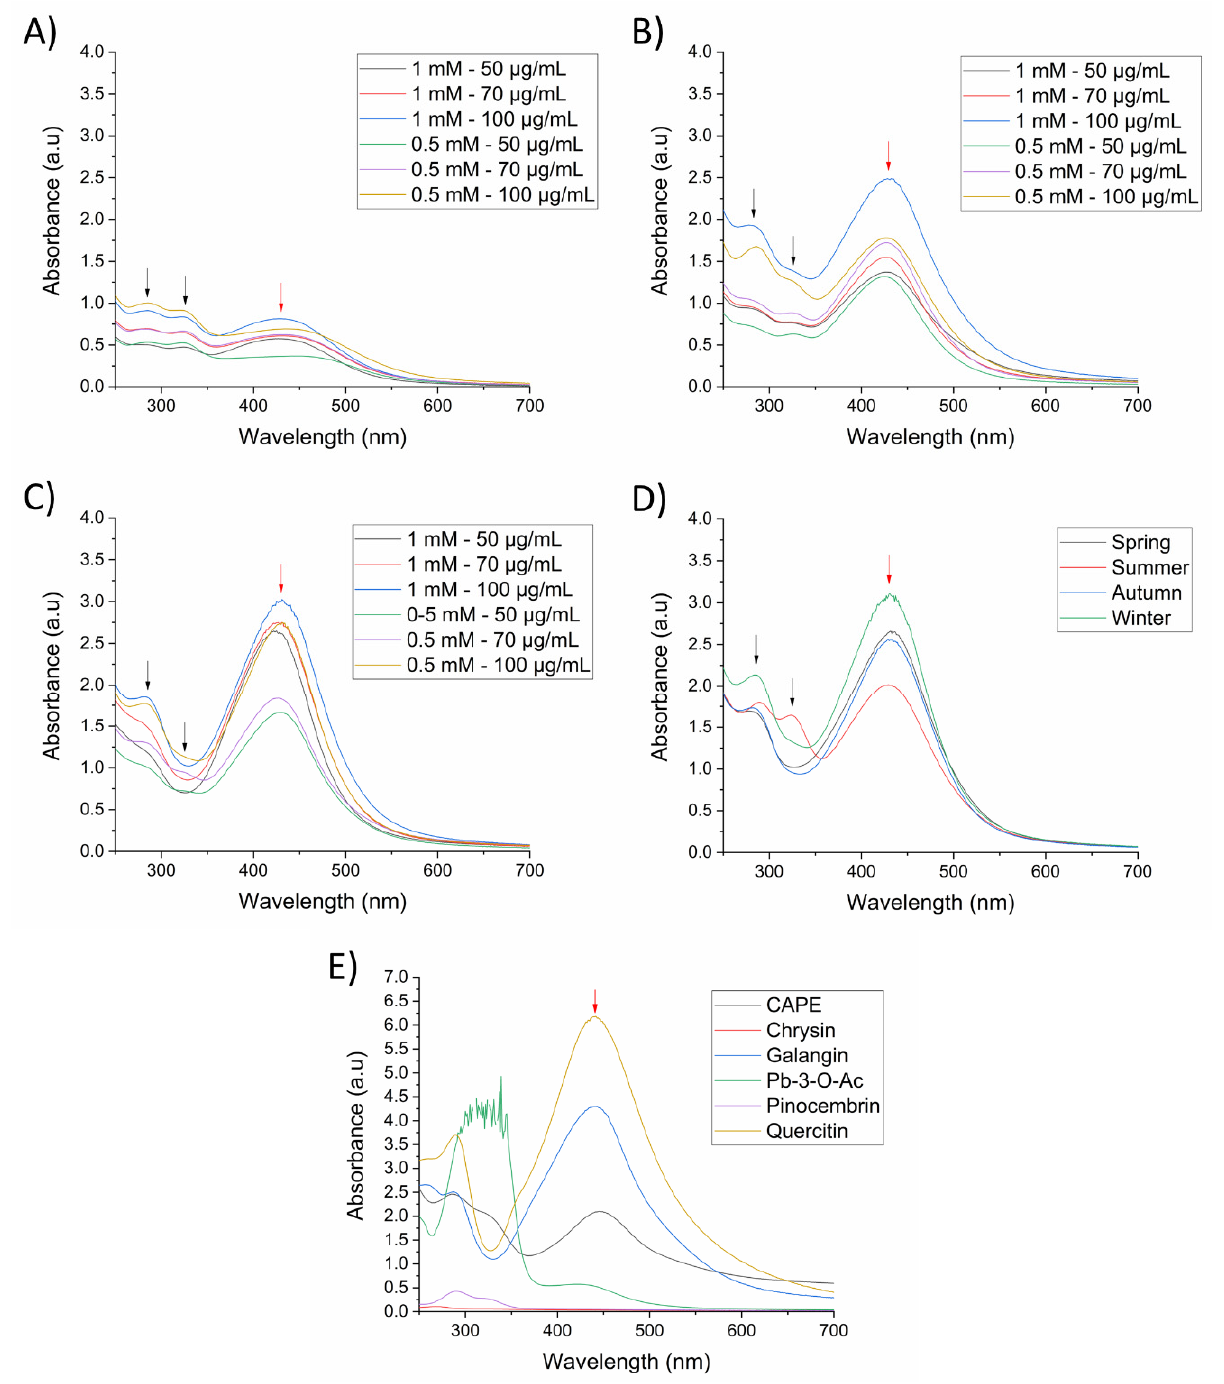
Figure 1. UV-Vis spectra of SP-AgNPs at different synthesis conditions (AgNO 3 —Propolis extract). ( A ) 25 ◦ C and 1 h reaction time; ( B ) 70 ◦ C and on 1 h reaction time; ( C ) 70 ◦ C and 2 h reaction time; ( D ) seasonal samples of SP-AgNPs; ( E ) AgNPs synthesized with propolis chemical constituents. The concentration of seasonal samples of SP and all chemical constituents used for the synthesis of AgNPs was 100 µ g/mL, except for quercetin (20 µ g/mL). Synthesis was carried out with 1 mM AgNO 3 at 70 ◦ C for 2 h. Black arrows (spectral bands at 280 and 330 nm of SP); red arrows (LSPR of silver nanoparticles). Pb-3-O-Ac: Pinobanksin-3-O-acetate. Spectra are representative of three independent